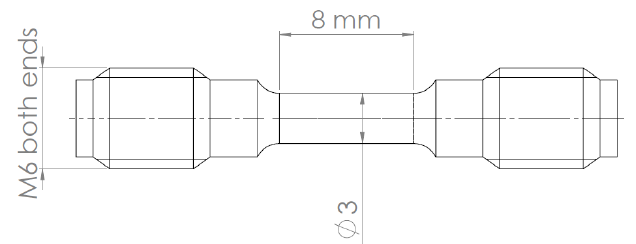
Fig. 1. Cylindrical specimen for the quasi-static and high-rate monotonic loading investigation.